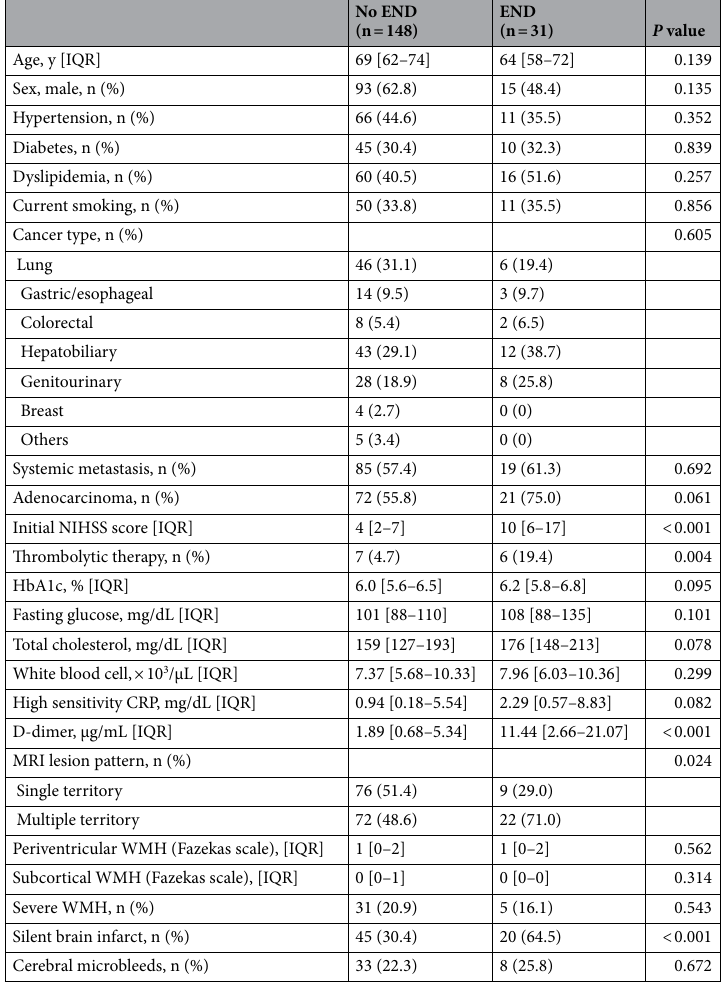
Table 1. Baseline characteristics of patients with and without early neurological deterioration. END = early neurological deterioration, NIHSS = National Institutes of Health Stroke Scale, CRP = c-reactive protein, MRI = magnetic resonance imaging, WMH = white mater